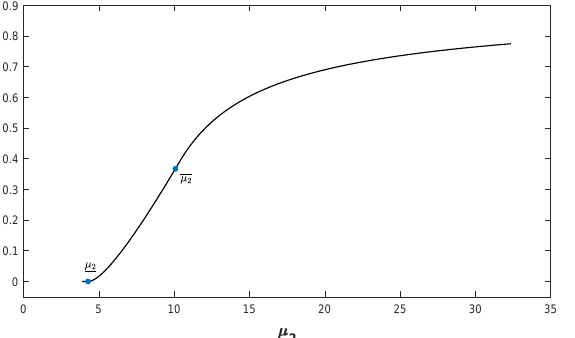
Figure 2. Total revenue gain ratio is increasing in µ 2 . ( V 1 = V 2 = 2.5, c 1 = 2, µ 1 = 10, Λ 1 = 12, c 2 = 0.5, Λ 2 = 3, α = β = 0.5). Total revenue gain ratio: ∇ π c / ( π 0